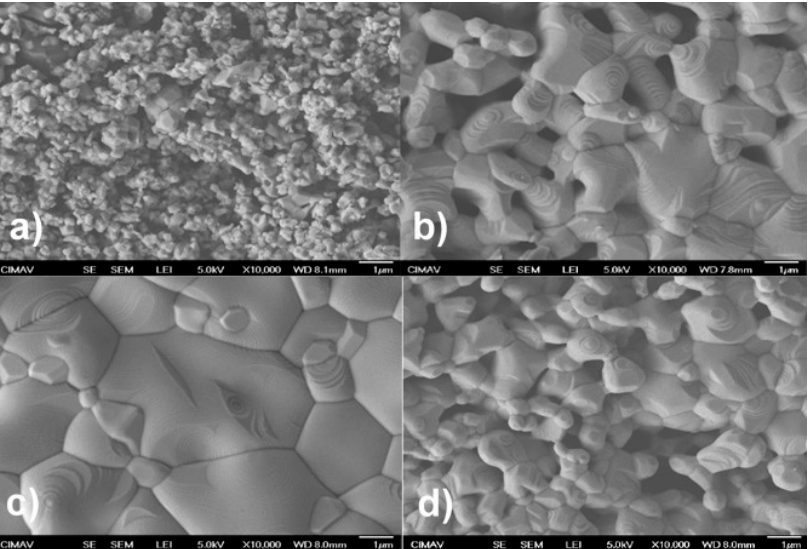
Figure 2. SEM images of manganites manufactured by: ( a ) microwave-assisted sol-gel; ( b ) Pechini sol-gel; ( c ) solid-state reaction with planetary mill; and ( d ) solid-state reaction with attrition